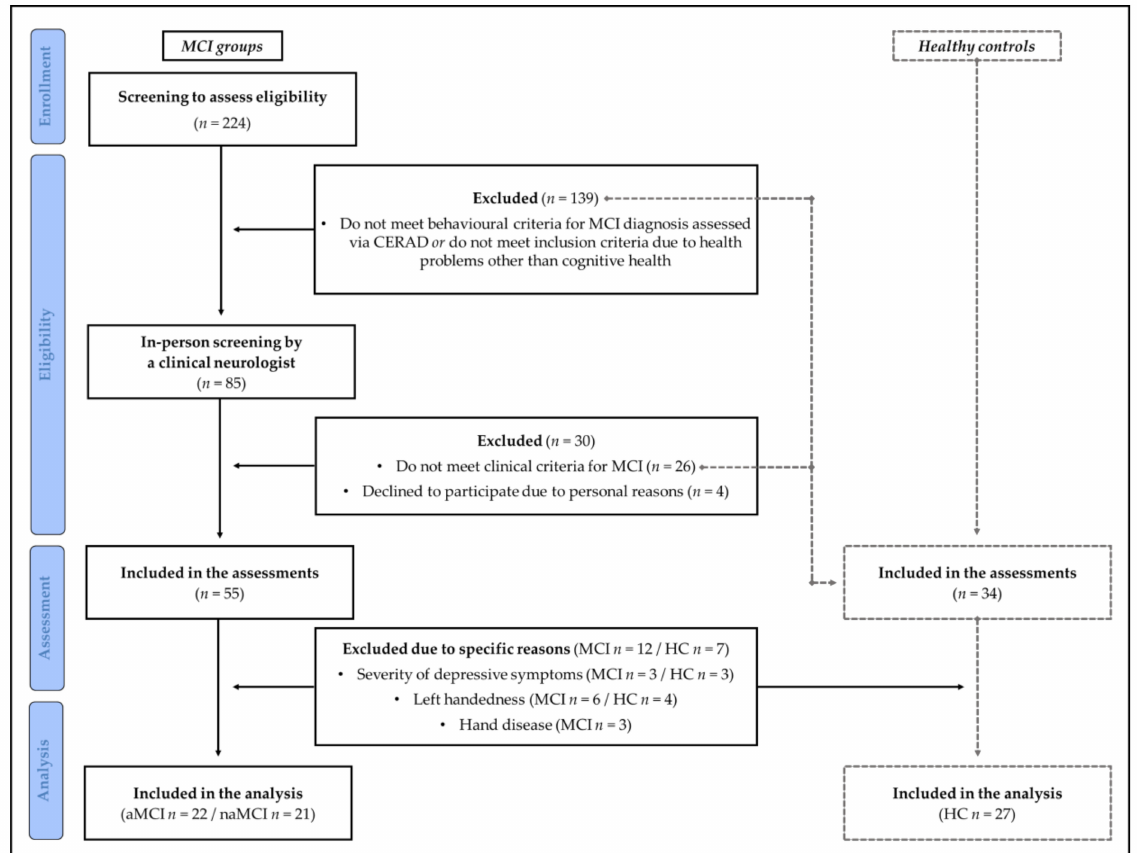
Figure 1. Flow diagram that schematically depicts the selection processes (from screening to assess eligibility to the final inclusion in the statistical analysis) and the reasons for exclusion. aMCI: amnestic mild cognitive impairment; CERAD: Alzheimer’s Disease Consortium to Establish a Registry test battery; HC: healthy controls; naMCI: non-amnestic mild cognitive